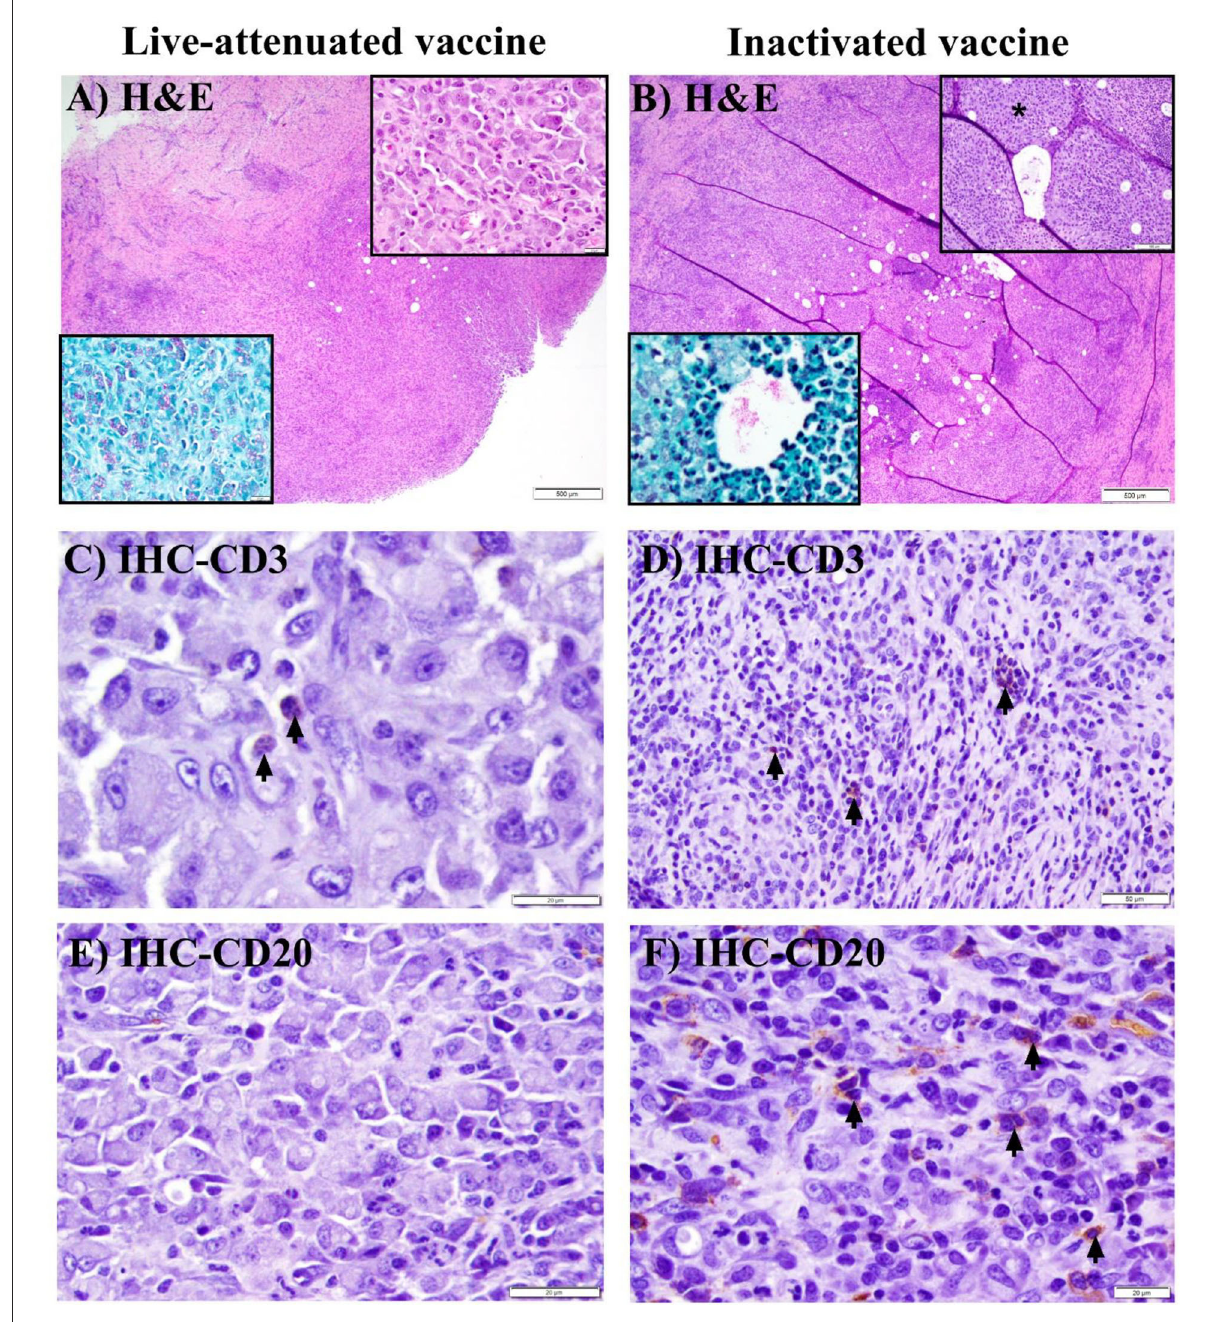
FIGURE4 Histopathology of granuloma formation in goats after immunization with live-attenuated or inactivated vaccines at 3 weeks post vaccination. (A, B) Hematoxylin and eosin (H&E) stained sections from subcutaneous granulomas at the site of injection of SC-vaccinated goats demonstrating granulomatous inflammation (A) to granuloma formation (B) (bars = 500 µ m). (A) Top (H&E) inset shows sheets of epithelioid macrophages, while the bottom (acid-fast stain) inset shows myriad intra-histiocytic acid-fast bacilli (AFB). (B) Top (H&E) inset displays degenerate neutrophils (asterisk) at the center of the granuloma, with intralesional bacilli in both H&E and acid-fast stain insets. (C, D) Immunohistochemical (IHC) staining of the sections in (A, B) with arrows pointing to minimal (C) or small (D) numbers of CD3 + T lymphocytes (bars are 20 & 50 µ m, respectively). (E, F) IHC staining of the sections in (A, B) with arrows pointing to small to moderate numbers of CD20 + B lymphocytes in F, with no detectable B lymphocytes in E (bars = 20 µ